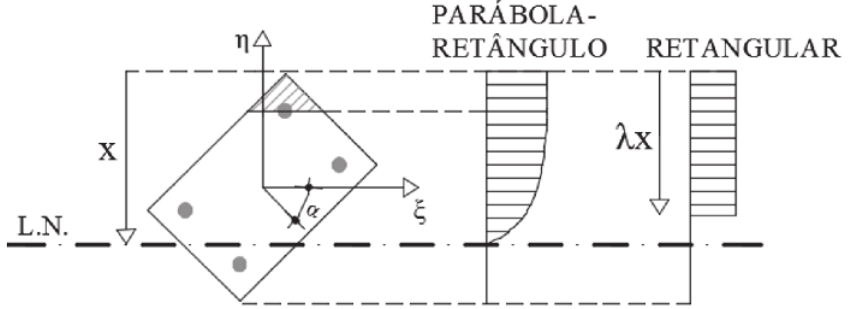
Comparação entre diagramas de tensão para direções